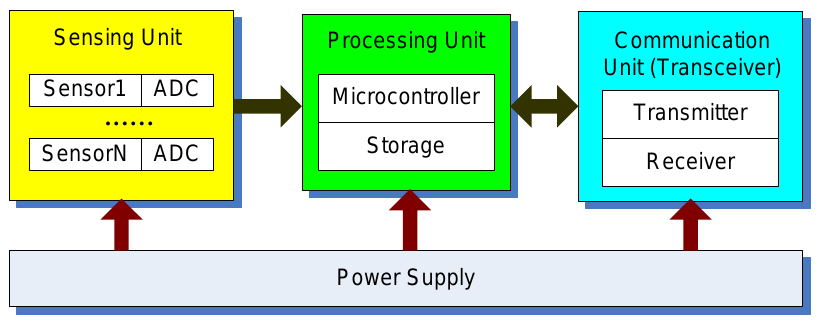
Figure 1. Wireless sensor